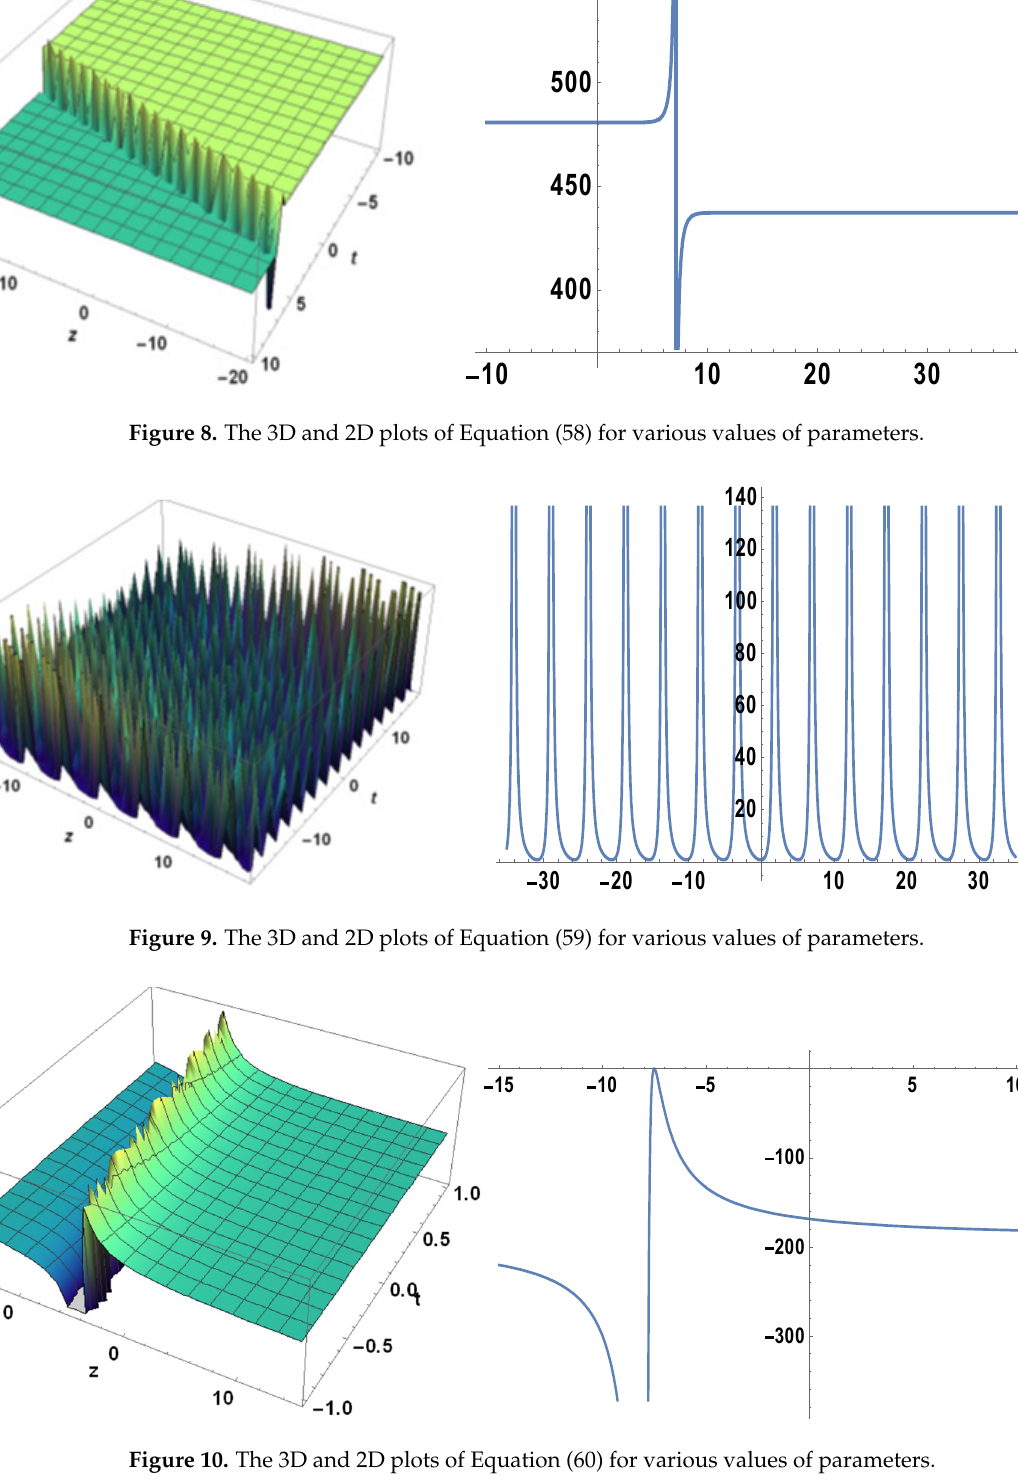
Figure 11. The 3D and 2D plots of Equation (61) for various values of parameters.